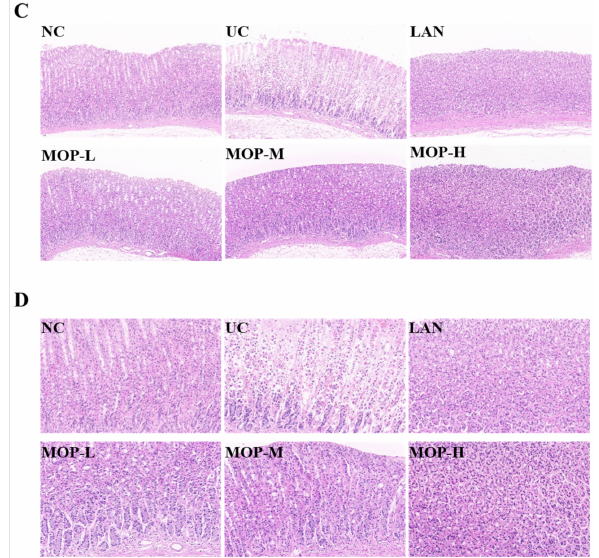
Figure 3. Macroscopic and microscopic injury of gastric mucosal of rats in all experimental groups (n = 10). ( A ) Representative macroscopic images of stomach tissue. ( B ) Effects of MOP on the ulcer index of ethanol-induced gastric mucosal injury. ( C ) Representative histological morphology of stomach tissues (magnification 200 × ). ( D ) Representative histological morphology of stomach tissues (magnification 400 × ). # and * denotes significant differences (n = 6). ## p < 0.01 vs. NC group; ** p < 0.01 vs. UC group.